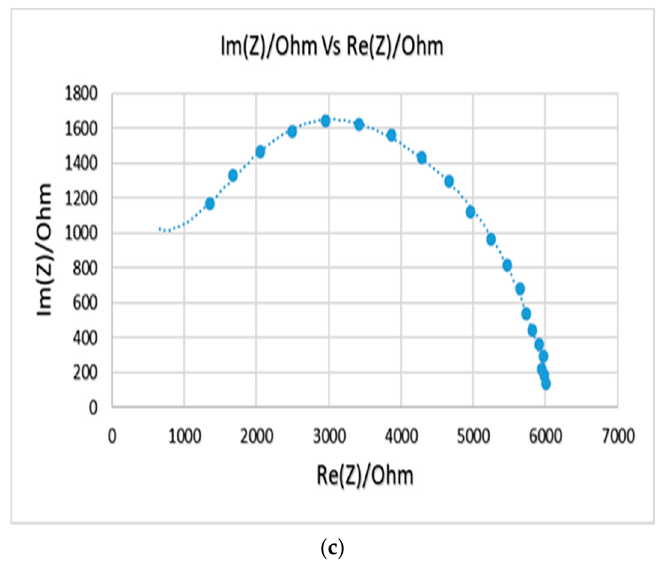
Figure 5. Nyquist plots for samples 4 ( a ), 5 ( b ), and 6 ( c ). Compositions are shown in Table 4. The CV test was performed to enable the investigation of the new samples’ stability (oxidation/reduction reactions) and the possible oxidation/reduction process, as shown in Figure 6. The samples did not show any oxidation/reduction peaks, so the samples are considered as stable samples. The charge storage capacity was calculated as explained earlier. The average charge storage capacity was found to equal 0.0730 C/cm 2 .